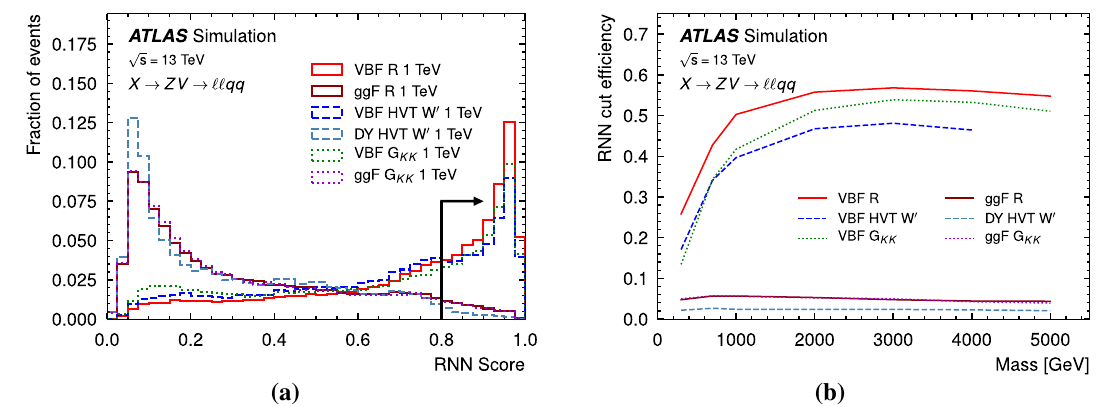
Fig. 3 a RNN score distributions for the production of a 1 TeV resonance in the signal models considered for this search; b the fractions of signal events passing the VBF requirement on the RNN score as functions of the resonance mass for both VBF and ggF production